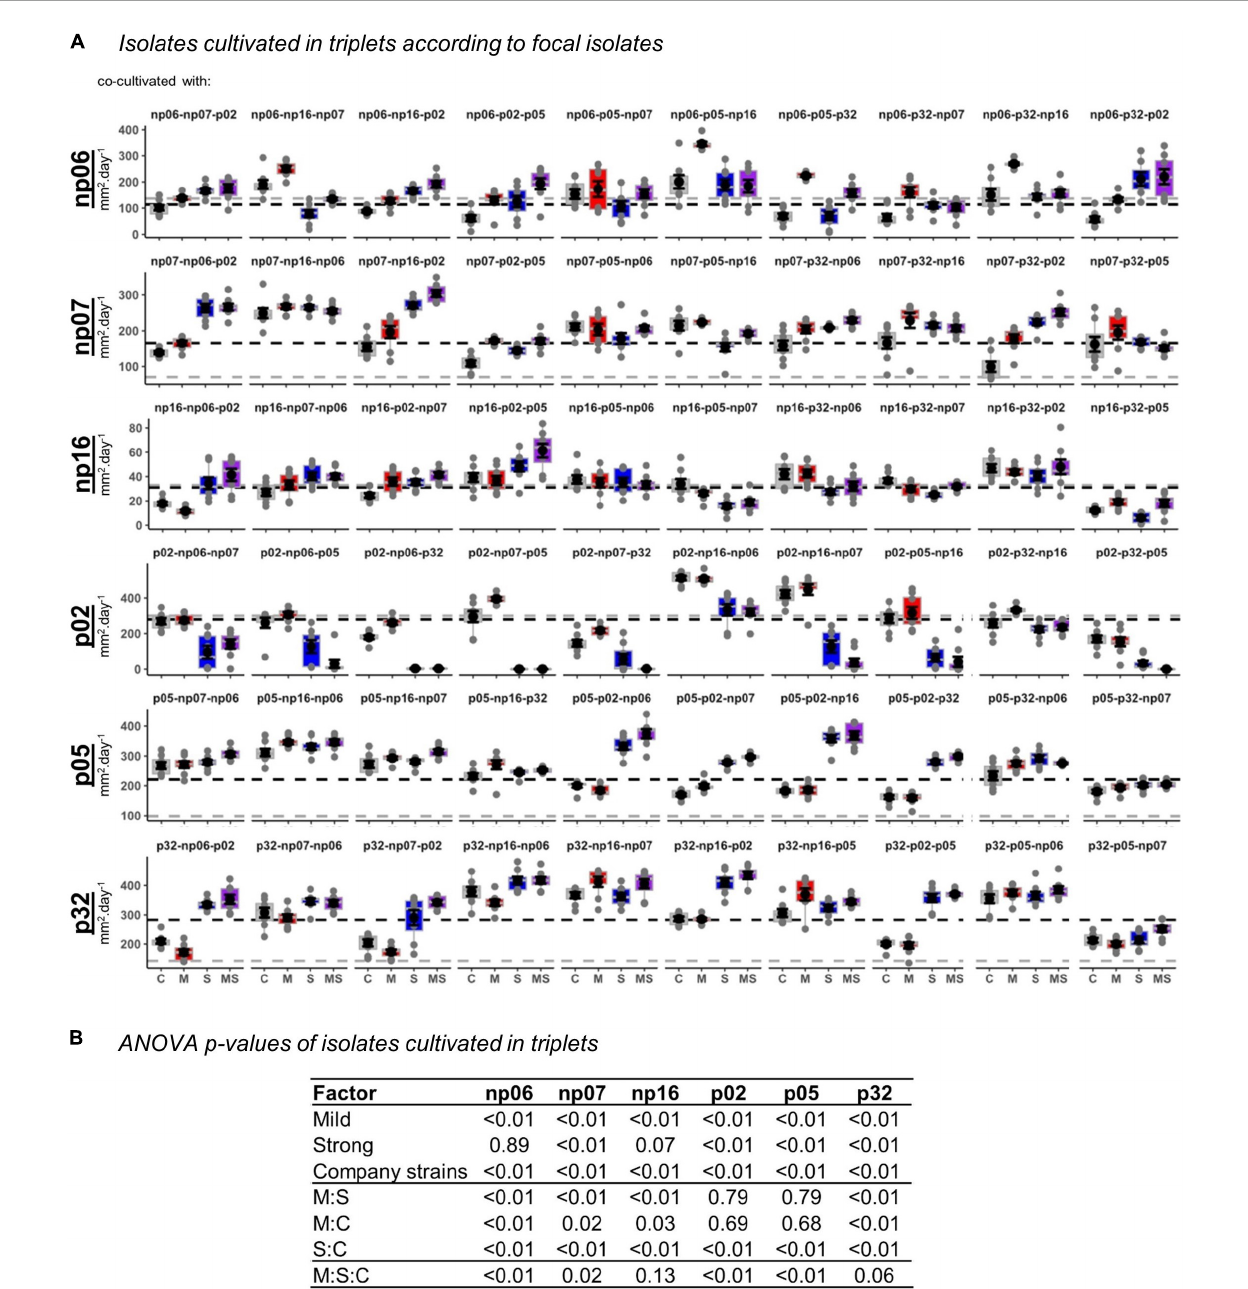
FIGURE5 The effects of none (control, C), mild (M), strong (S), and both (MS) heat stress events on fungal isolate growth rates for fungal isolates cultivated in triplets. The panel containing box-plots with average and standard error of each focal isolate according to the triplets (A) , and the robust analysis of variance (rANOVA) p -values for the isolates analyzed in a factorial design considering the heat treatments mild (yes or no), strong (yes or no) and company strains combinations (B) . For the boxplots, the gray lines are references to the isolates growing alone in control conditions (data from Supplementary Figure 2 ) and the black lines are the average of all controls for each focal